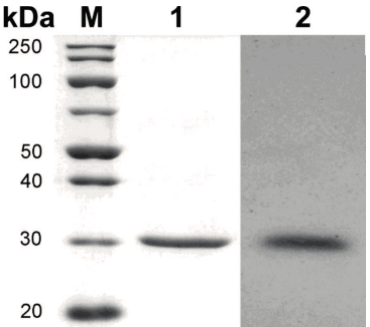
Figure 4. SDS-PAGE and zymography of purified recombinant HydS14. Lane M , molecular